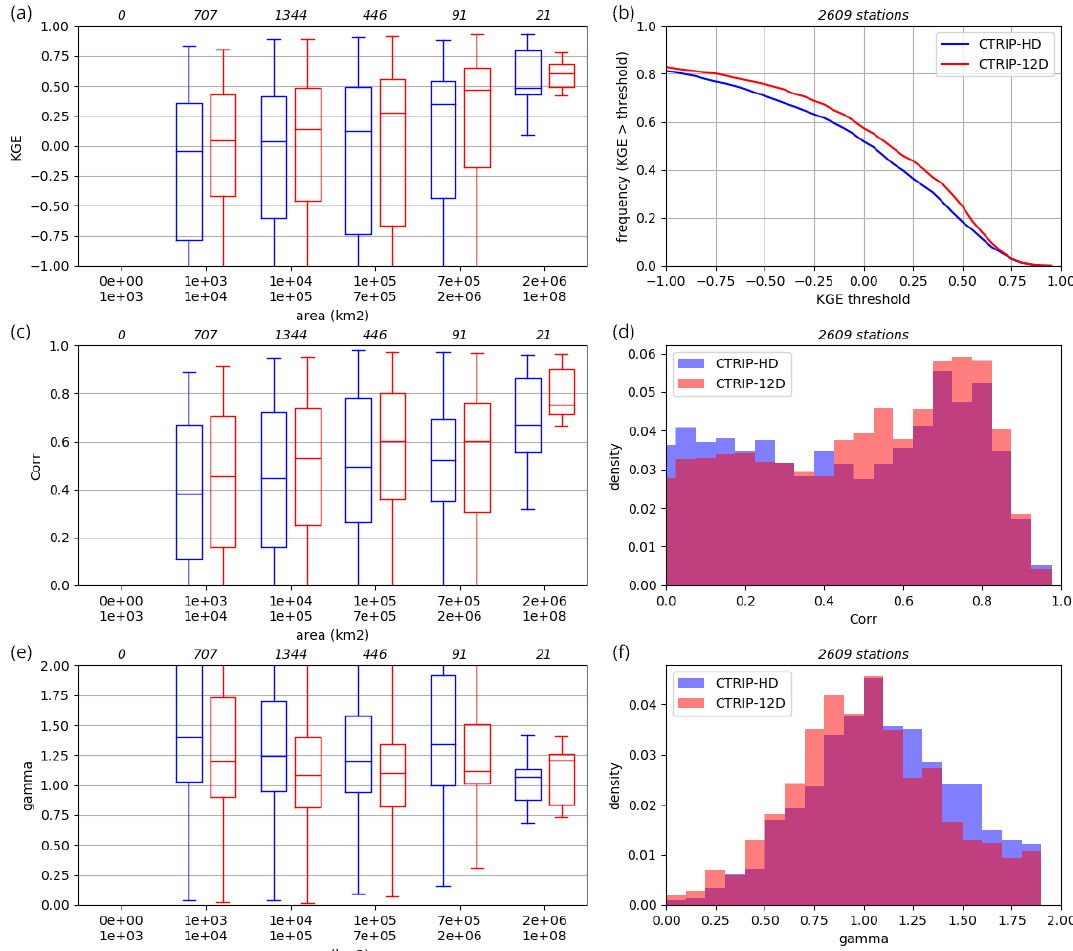
Figure 17. Panels (a, c, e) show the distributions of the KGE (a) , correlation r (c) and γ coefficient (e) with respect to the drainage area at each station for both CTRIP-HD and CTRIP-12D (numbers above the boxes represent the number of stations within each area bin). Panels (b, d, f) show the cumulative density function of the KGE (b) and the probability density functions of the correlation r (d) and γ coefficient (f)